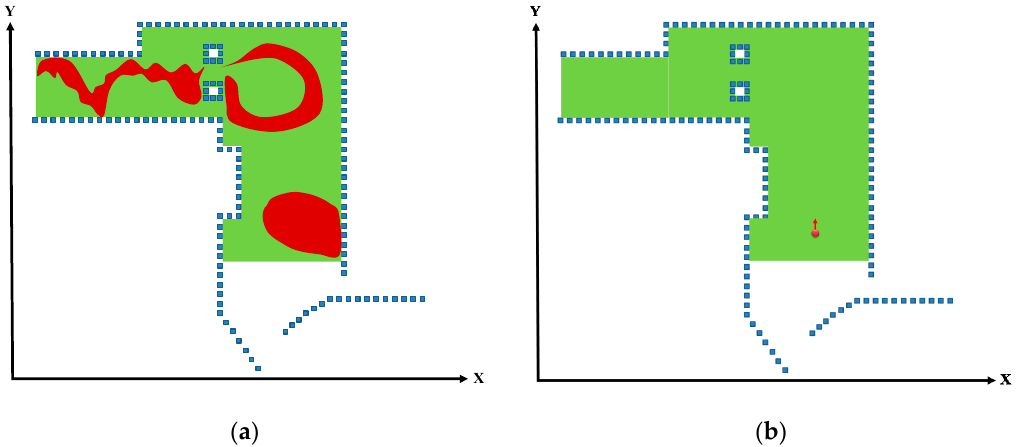
Figure 7. Identification of the initial location and direction of the vehicle through the mean energy method. ( a ) Possible vehicle locations identified through the mean energy method. ( b ) Initial location and direction identified through the feature registration. and direction identified through the feature